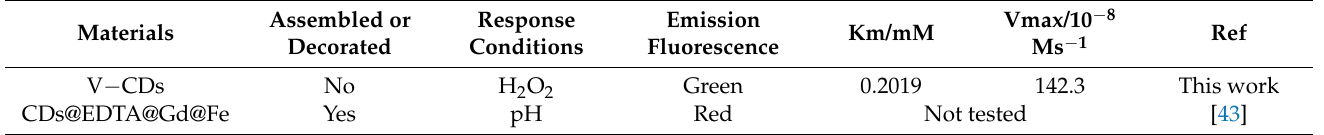
Table 1. Comparison with other types of CDs previously reported in terms of stability, cell imaging, and